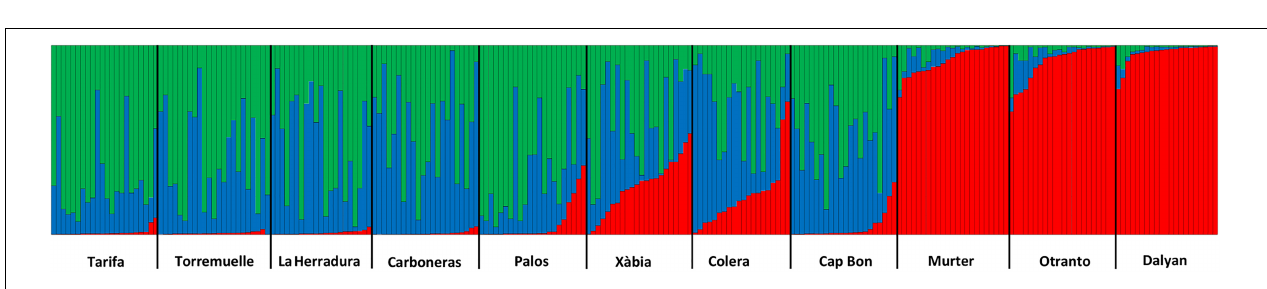
FIGURE 4 | Results of the STRUCTURE analysis using k = 3.